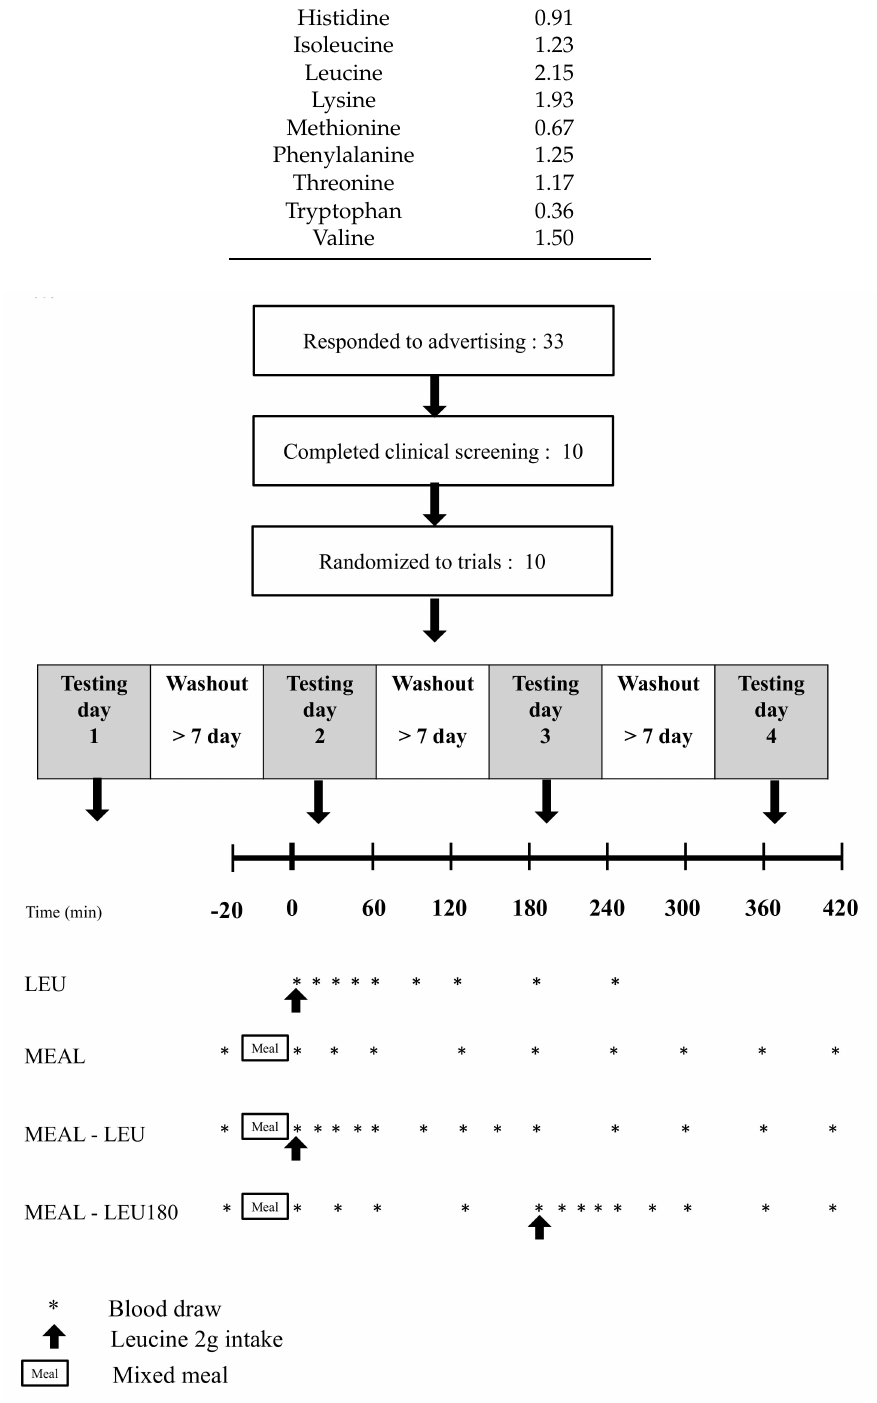
Figure 1. Schematic representation of the study design and timeline. LEU, intake of leucine only; MEAL, intake of a mixed meal only; MEAL-LEU, intake of a mixed meal with leucine intake immediately afterwards; MEAL-LEU180, intake of a test mixed meal followed by leucine intake after 180